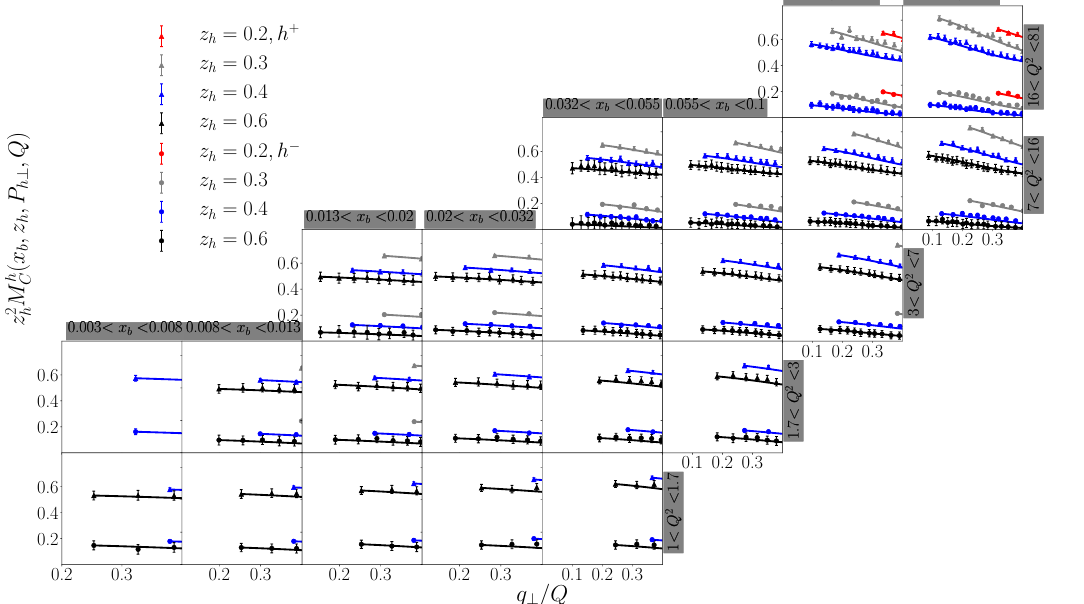
Figure 5 . The COMPASS multiplicity in [61] for charged hadron production from a deuteron target is compared with the normalized theory curve. The triangular points represent the h + data points while the circular data points represent the h − data points. For better presentation, the h + data is offset by a factor of 0 . 4